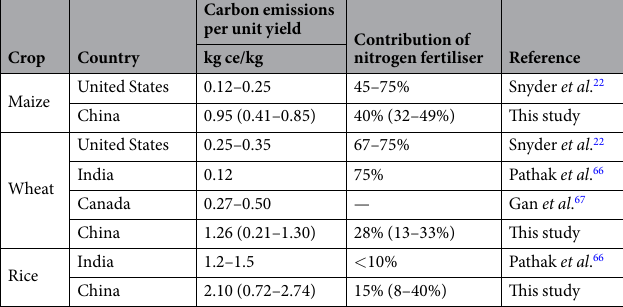
Table 3. Comparison of carbon emissions from China and other